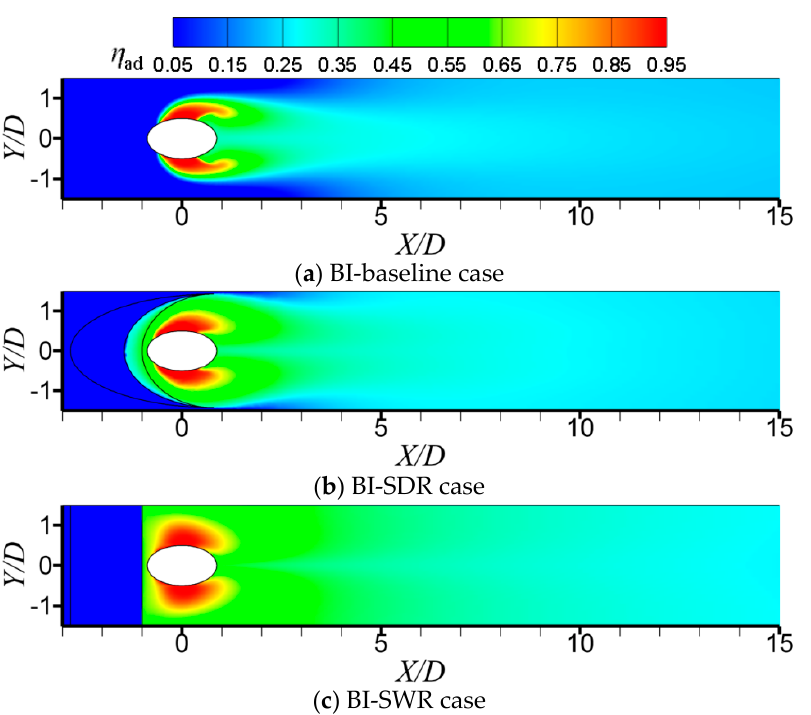
Figure 14. Adiabatic film cooling effectiveness distributions in BI cases under M = 1.5.